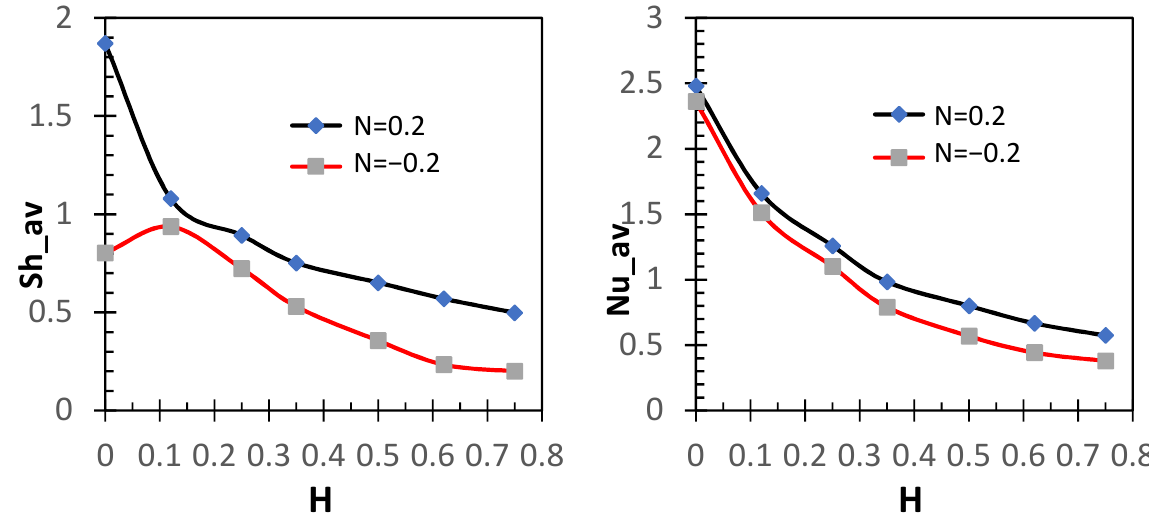
Figure 21. Effect of the barrier height on the average heat and mass transfer ratios for Ra = 2 × 10 4 , N = 0.2 and N = −0.2.